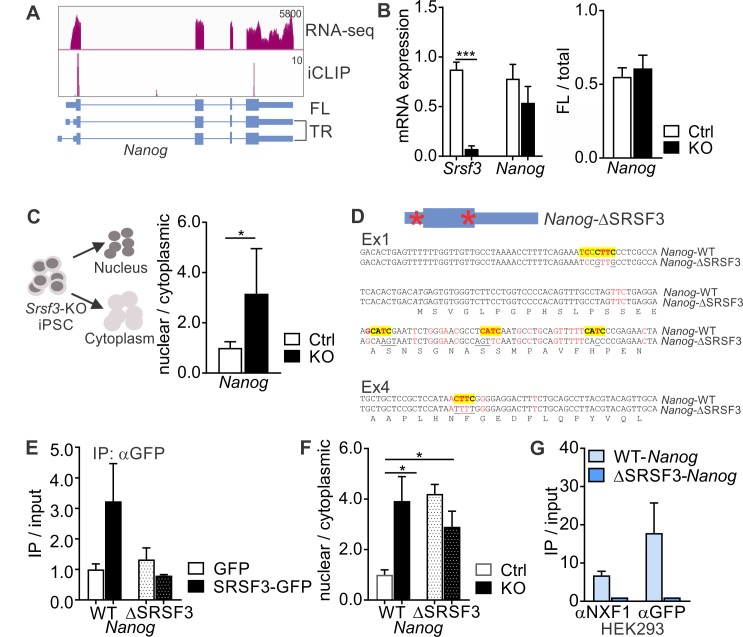
SRSF3 binding and mRNA export adaptor activity in independent of splicing and essential for Nanog mRNA export.(A) Nanog expression and SRSF3 iCLIP binding profile within Nanog transcript region. Gene diagram depicting Nanog variants is presented below the graphs (FL = full length, TR = truncated). (B) Left: RT-qPCR quantification of Srsf3 and Nanog mRNA expression in Srsf3-KO (KO) and control (Ctrl) iPSCs 24 hr after 4OHT induction. The data is normalised to Hprt and presented relative to control iPSCs (***p<0.001, Unpaired Student’s t-test, two-tailed, data as mean ± SEM, n = 3). Right: Quantification of FL Nanog transcript levels relative to total Nanog mRNA levels (p>0.05, Unpaired Student’s t-test, two-tailed, data as mean ± SEM, n = 3). (C) Srsf3-KO (KO) and control (Ctrl) iPSCs were fractionated into nuclear, cytoplasmic and total fractions 24 hr after 4OHT induction (left). Quantification of Nanog mRNA levels in the nuclear and cytoplasmic fractions (right). Data is presented as nuclear to cytoplasmic ratio (*p<0.05, Unpaired Student’s t-test, two-tailed, data as mean ± SEM, n = 5) and normalised to control. #error bar smaller than the border line. (D) Generation of WT-Nanog and ΔSRSF3-Nanog expression constructs. Both constructs contain the complete Nanog cDNA, including 5’ and 3’ UTRs. In ΔSRSF3-Nanog, synonymous mutations have been introduced to remove SRSF3 binding sites (positions within the transcript denoted by red asterisks in the gene diagram). SRSF3 crosslink nucleotides are shown in red, SRSF3 consensus sequences are highlighted in yellow, and the underlined nucleotides were mutated to abolish SRSF3 consensus binding sites without affecting the coding potential. (E) RNA immunoprecipitation (IP) of WT- and ΔSRSF3-Nanog mRNA in SRSF3-GFP or GFP-only expressing pluripotent cells. The Nanog mRNA enrichment is presented as IP/input and normalised to GFP-only control cells expressing WT-Nanog (mean ± SEM, n = 2). (F) Srsf3-KO (KO) and control (Ctrl) iPSCs expressing WT-Nanog or ΔSRSF3-Nanog were fractionated into nuclear, cytoplasmic and total fractions 24 hr after 4OHT. Quantification of WT-Nanog and ΔSRSF3-Nanog mRNA levels in the nuclear and cytoplasmic fractions is presented as nuclear to cytoplasmic ratio and normalised to the control cells expressing WT-Nanog (*p<0.05, One-way ANOVA, data as mean ± SEM, n = 3). (G) RNA immunoprecipitation of WT- and ΔSRSF3-Nanog mRNA in SRSF3-GFP or GFP-only expressing HEK293 cells. Anti-NXF1 and anti-GFP antibodies were used to enrich mRNAs bound by NXF1 and SRSF3-GFP, respectively. The Nanog mRNA enrichment is presented as IP/input and normalised to GFP-only cells expressing WT-Nanog (mean ± SEM, n = 2). See also Figure 4—figure supplement 1.